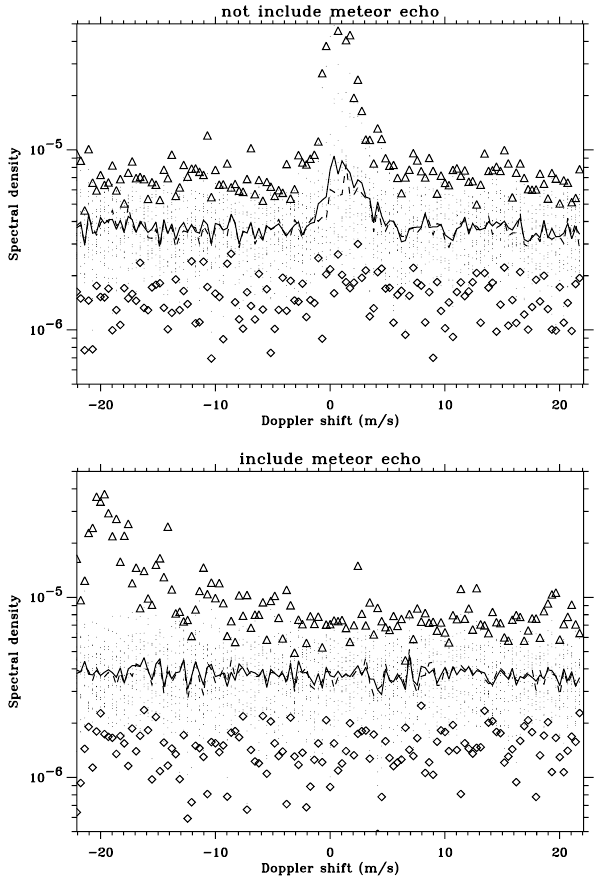
Fig. 2. Observed Doppler spectra with pure turbulence echoes (up- per panel) and including meteor echoes (lower panel). Each dot is the spectral density measured on a one minute observation. In total, 20 spectra are plotted in the figure. Triangles and squares show the 5% (1 of 20 spectra) largest and smallest spectral density points. The solid and dashed lines show the spectra calculated with the im- proved integration and the median, respectively.